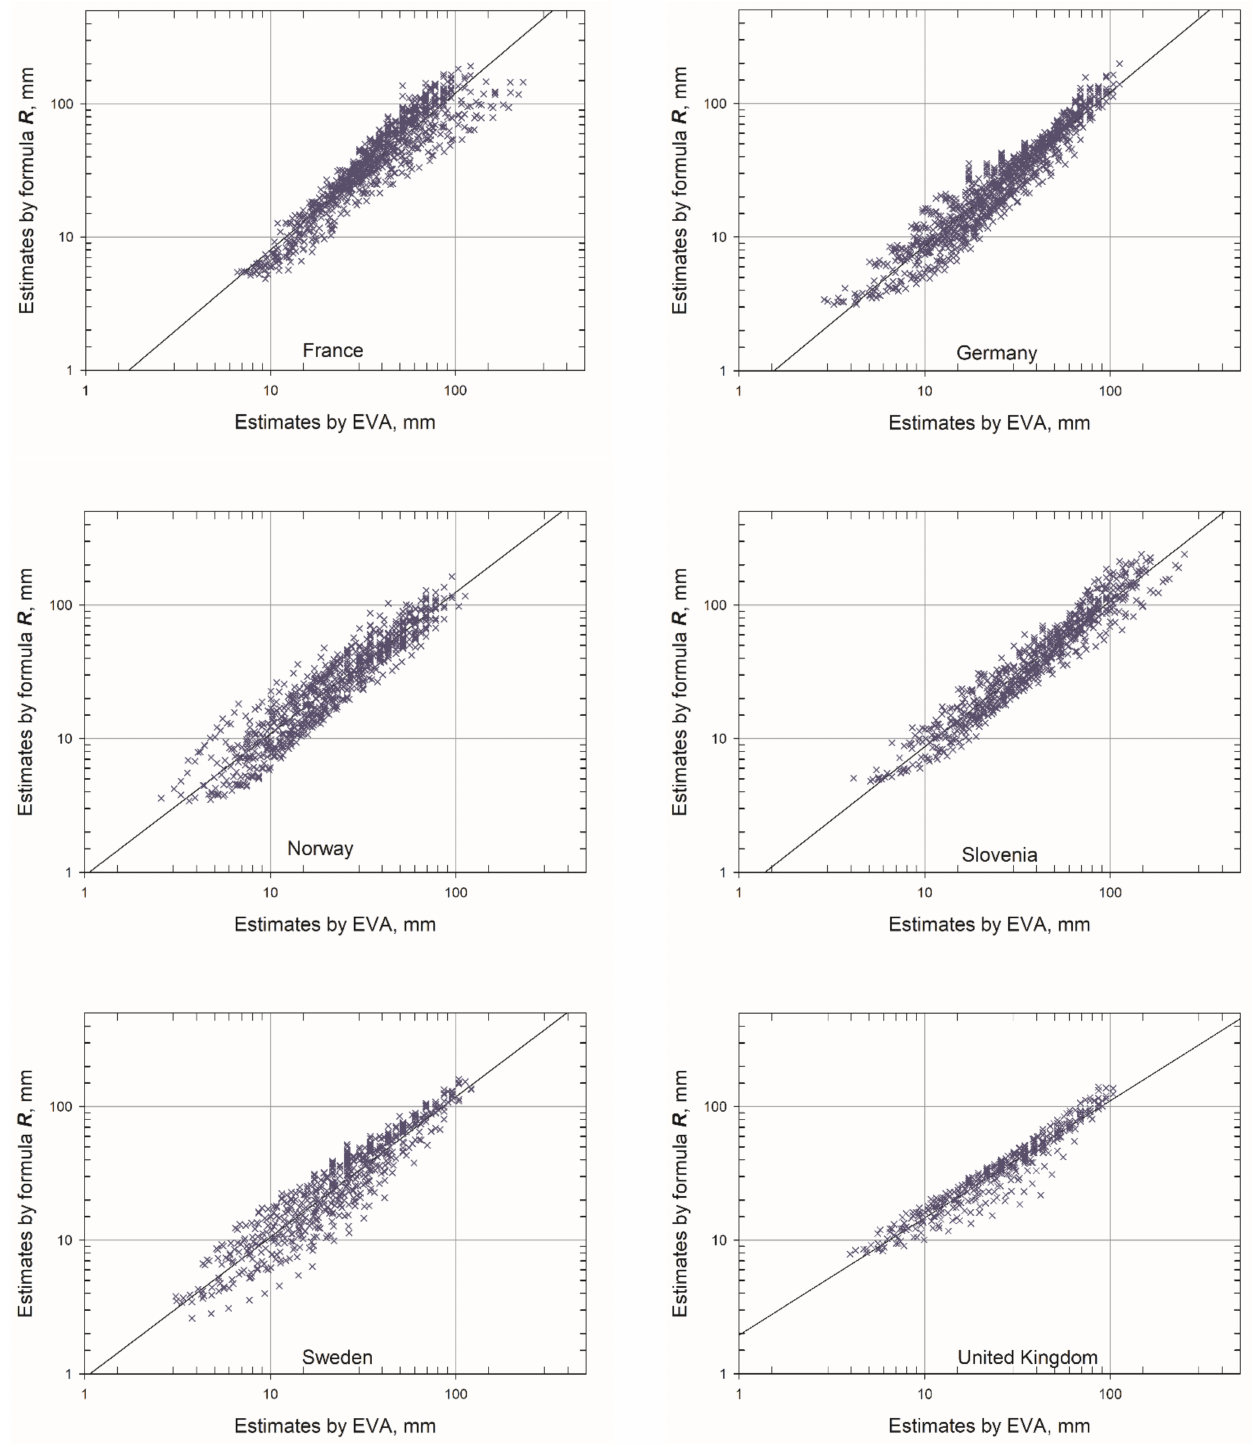
Figure 6. Examples of application of formula R on rain intensity information from some European